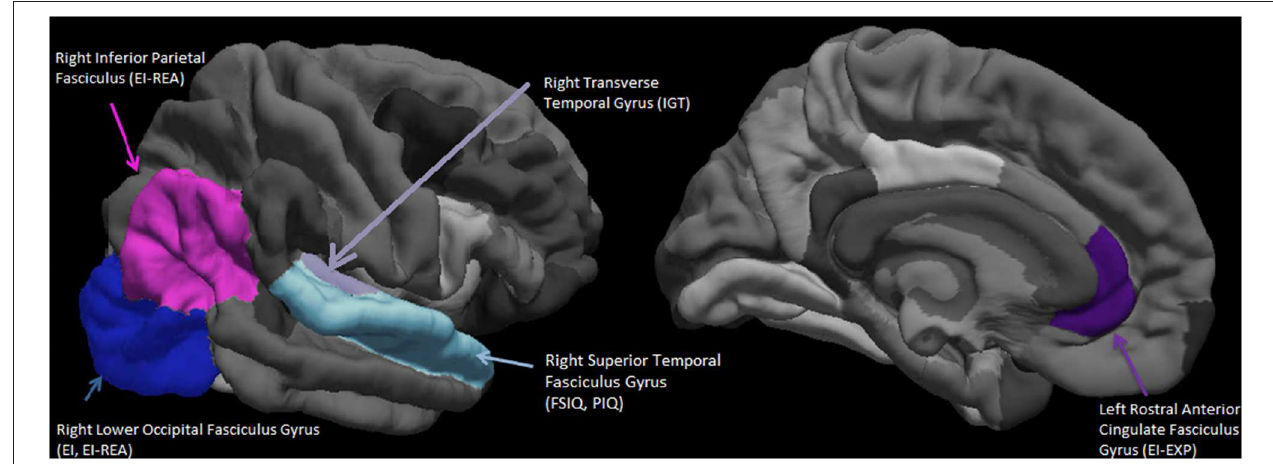
FIGURE 2 | Visual representation (on the Freesurfer software template) of the average cortical thicknesses of the significant Regions of Interest (ROIs). These are predictive of emotional intelligence index score (EI), its area sub-scores Experiential Emotional Intelligence (EXP), Strategic Emotional Intelligence (REA); Full scale cognitive intelligence index score (FSIQ), its sub-score Performance Intelligence Quotient (PIQ), and the IOWA Gambling Task score. N =